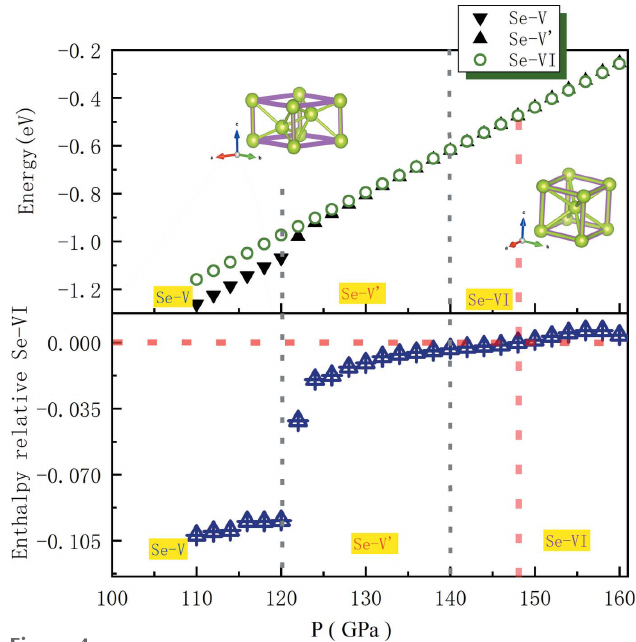
Figure 4 Energy of Se-V 0 and Se-VI (relative to the Se-V structure) as a function of pressure from 110 to 160